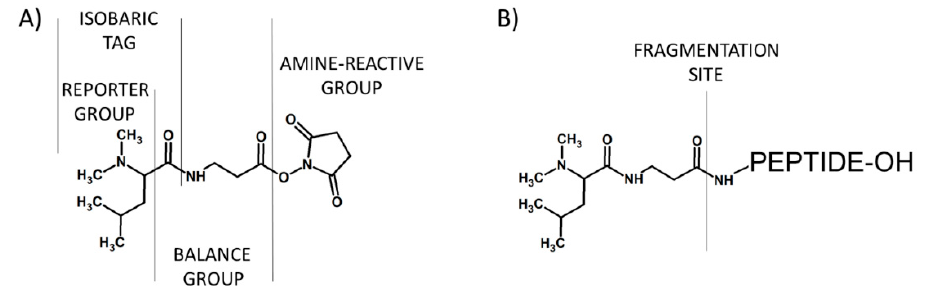
Figure 7. Schematic presentation of Deuterium isobaric Amine Reactive Tag (DiART) [32] ( A ) and DiART modified peptide ( B ).